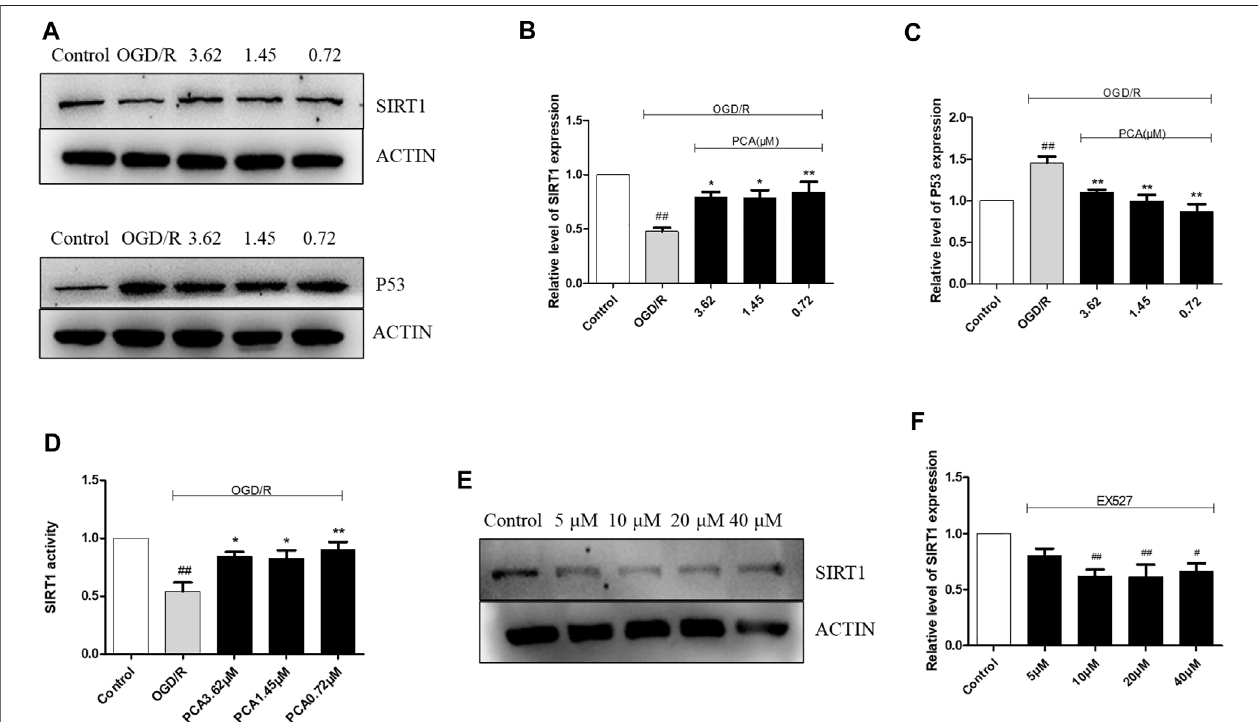
FIGURE6| EffectsonSIRT1and P53expression and activity. (A – C) Representativeimages ofWB analysisandthesemi-quanti fi cation ofSIRT1,P53inHUVECs. (D) PCAcanincreaseSIRT1activityafterOGD/R-inducedinjury (E,F) ExpressionlevelsofSIRT1proteinsunderdifferentconcentrationsofEX527(5 – 40 μ M).Thevalues are expressed as the mean ± SD ( n = 3). ## p < 0.01, # p < 0.05 vs. Control, ** p < 0.01, * p < 0.05 vs.